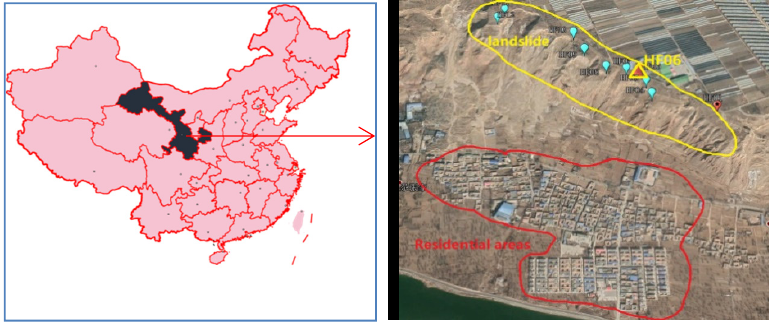
Figure 10. Location of the Heifangtai landslide.